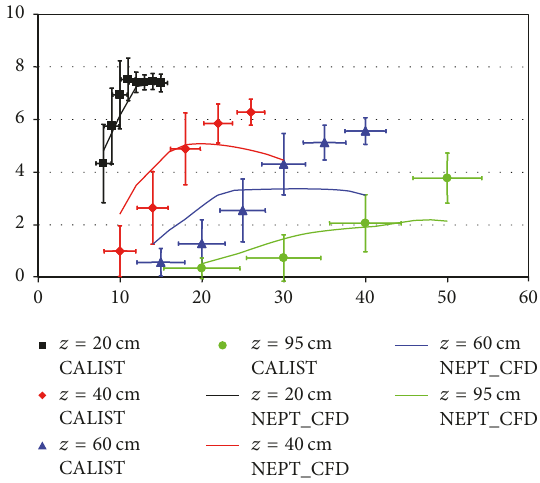
Figure 37: Radial velocity of droplets (m/s) versus radial distance (cm), monodispersed approach.